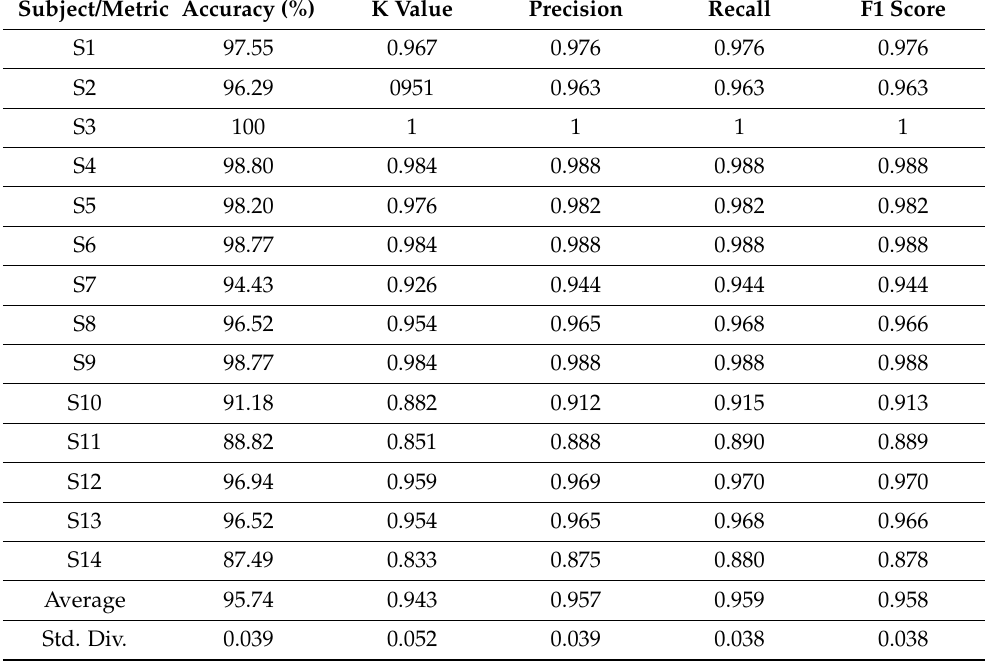
Table 7. Performance metrics on the HGD dataset using the FMBEEGCBAM.